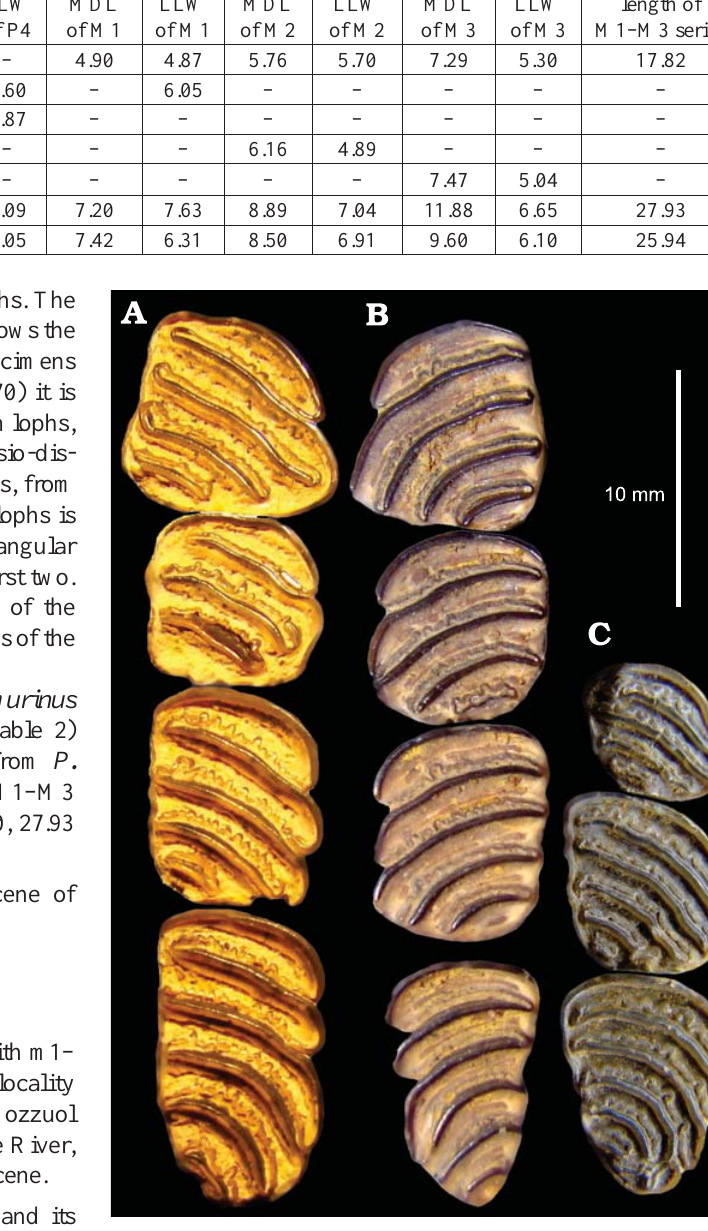
Fig. 3. Comparison of the occlusal surface in potamarchine rodents Potamarchus murinus Burmeister, 1885 ( A , B ) from Ituzaingó Formation, Late Miocene, Argentina and Potamarchus adamiae sp. nov. ( C ) from Solimões Formation, Late Miocene, Brazil. A . MACN-Pv 3500, P4–M3 series. B . MACN-Pv 5870, P4–M3 series. C . UFAC-CS 11, M1–M3 series.